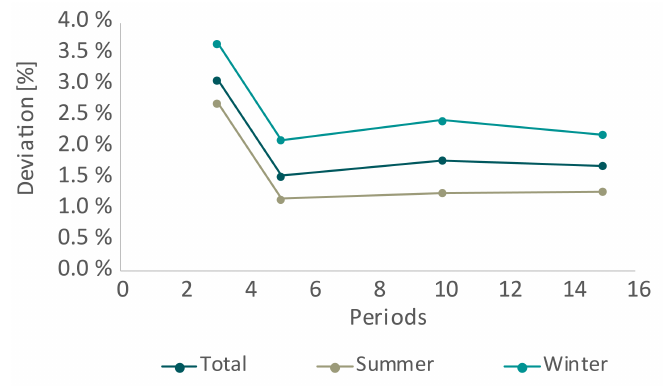
Figure 3. Average differences in operational